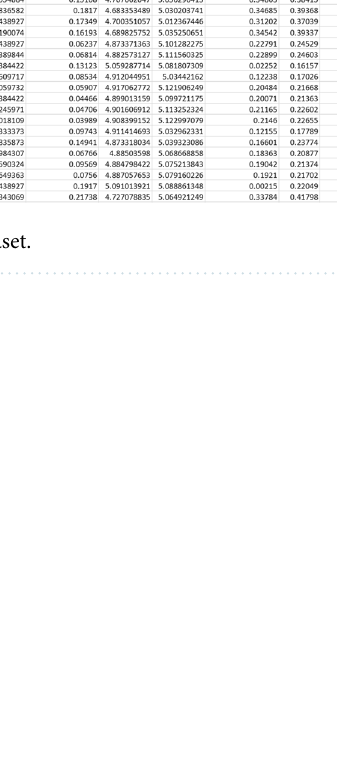
Figure 9. Percentage of samples of the two classes in the dataset (True = 1) and (False =